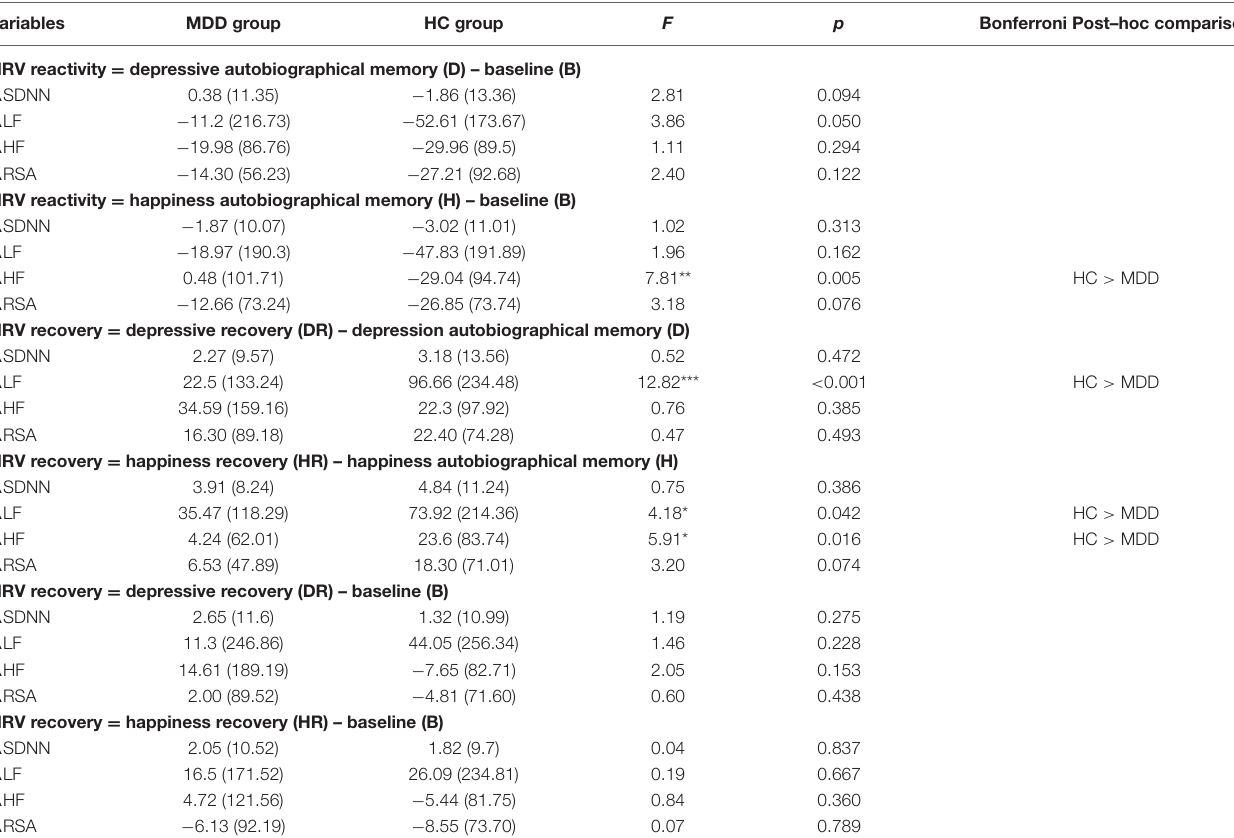
TABLE 3 | The HRV reactivity and HRV recovery between the MDD and HC groups.